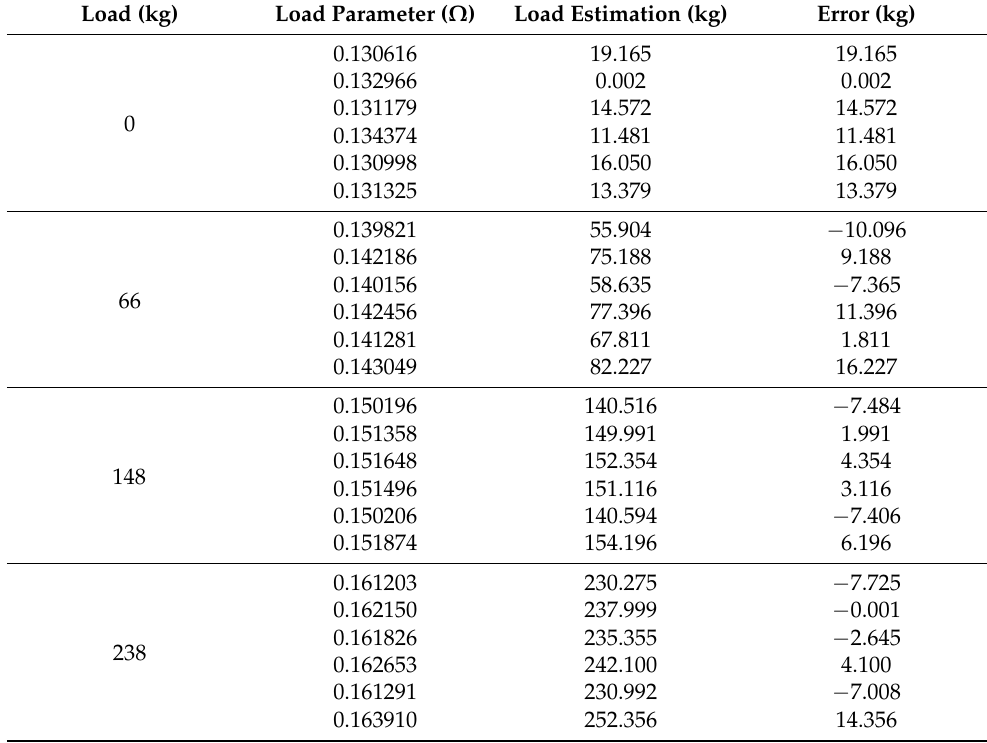
Figure A6. Load measurement error for a three-door Volkswagen Polo. For details see the caption of Figure 6. Table A4. Measurement data for Volkswagen Polo 3d test